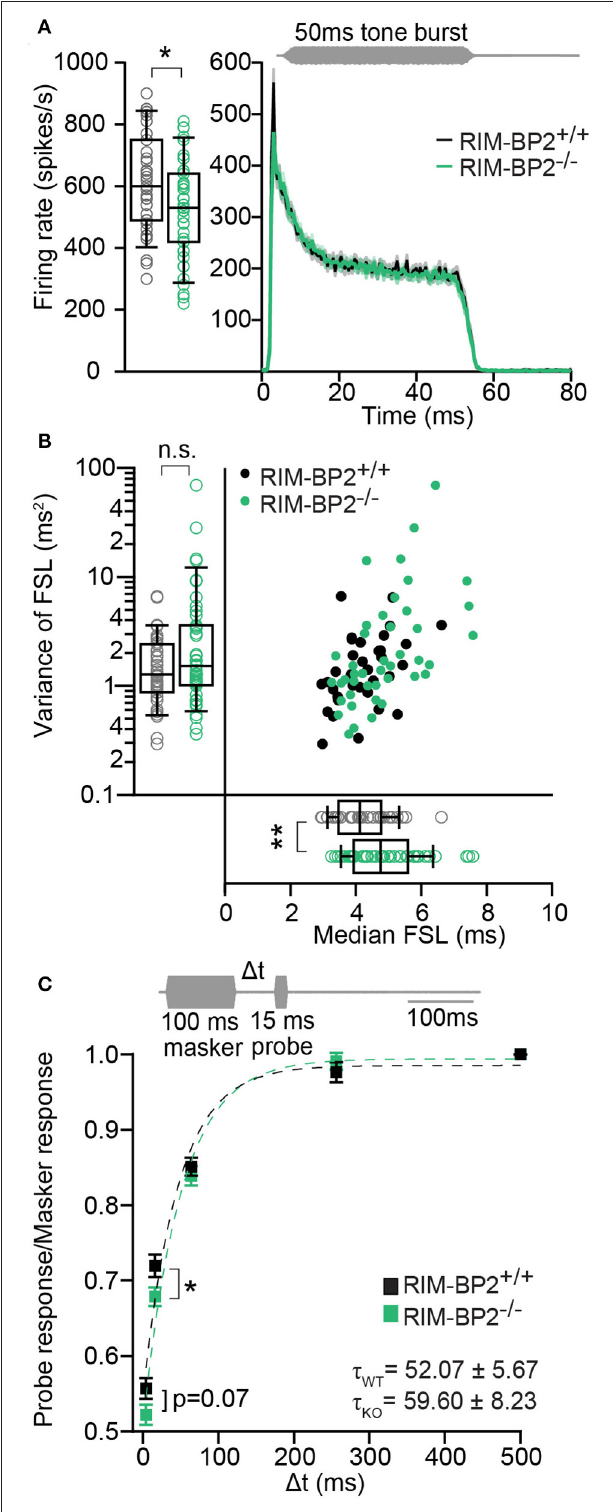
FIGURE 12 | RIM-BP2 − / − auditory nerve fibers have reduced onset firingrates,anincreasedpostsynapticfirstspikelatencyandslowerrecovery. (A)